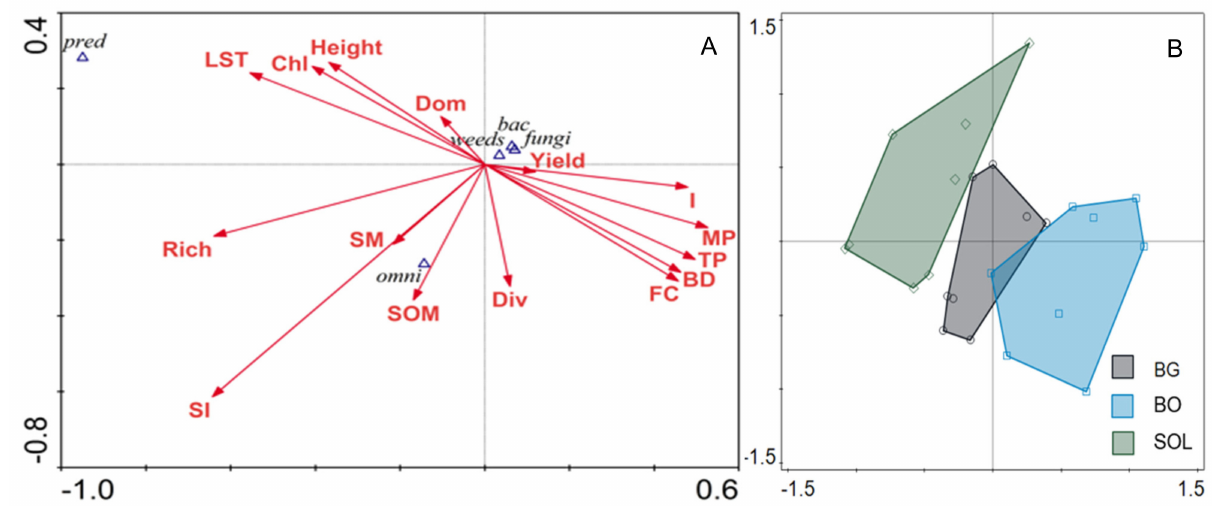
Figure 4. ( A ) Ordinance diagram of trial II depicting the first two canonical axes of a canonical corre- spondence analysis between free-living nematode abundance (bac = bacterivores; fungi = fungivores; herb = herbivores; omni = omnivores; pred = predatory nematodes) and environmental variables (BD = bulk density; Div = diversity; Dom = dominance; FC = field capacity; I = infiltration rate; TP = total soil porosity; MP = macroporosity; SOM = soil organic matter; SM = soil moisture; LST = lowest daily soil temperature; Yield = corn yield; Chl = chlorophyll content; Height = corn height; Rich = richness; and SI = structure index). The first two axes explained 94.0% of the variance. ( B ) Scatter plot of samples on the first two principal component axes explaining 62.8% of the total variance from no-till black oat (BO), bare ground (BG), and solarization (SOL)